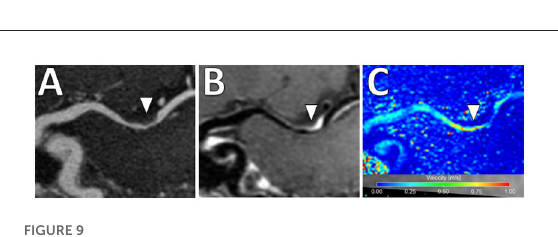
FIGURE9 4D Flow MRI of intracranial atherosclerosis. (A) TOF MRA image demonstrates a focal area of middle cerebral artery narrowing (arrowhead) with (B) post-contrast T1-weighted VW-MRI showing a corresponding eccentric, enhancing atherosclerotic plaque (arrowhead). (C) On 4D Flow MRI, increased velocities are seen in the area of greatest narrowing